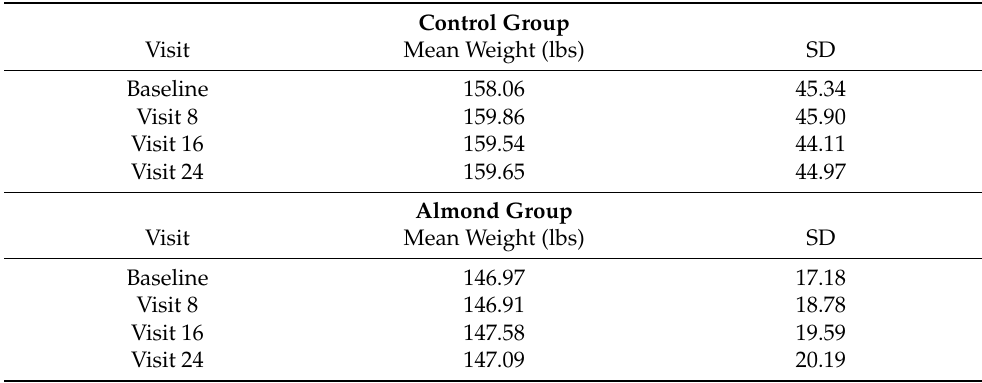
Table 2. Mean and standard deviation (SD) of the weight of participants in the control group and almond group (in pounds) at each visit.